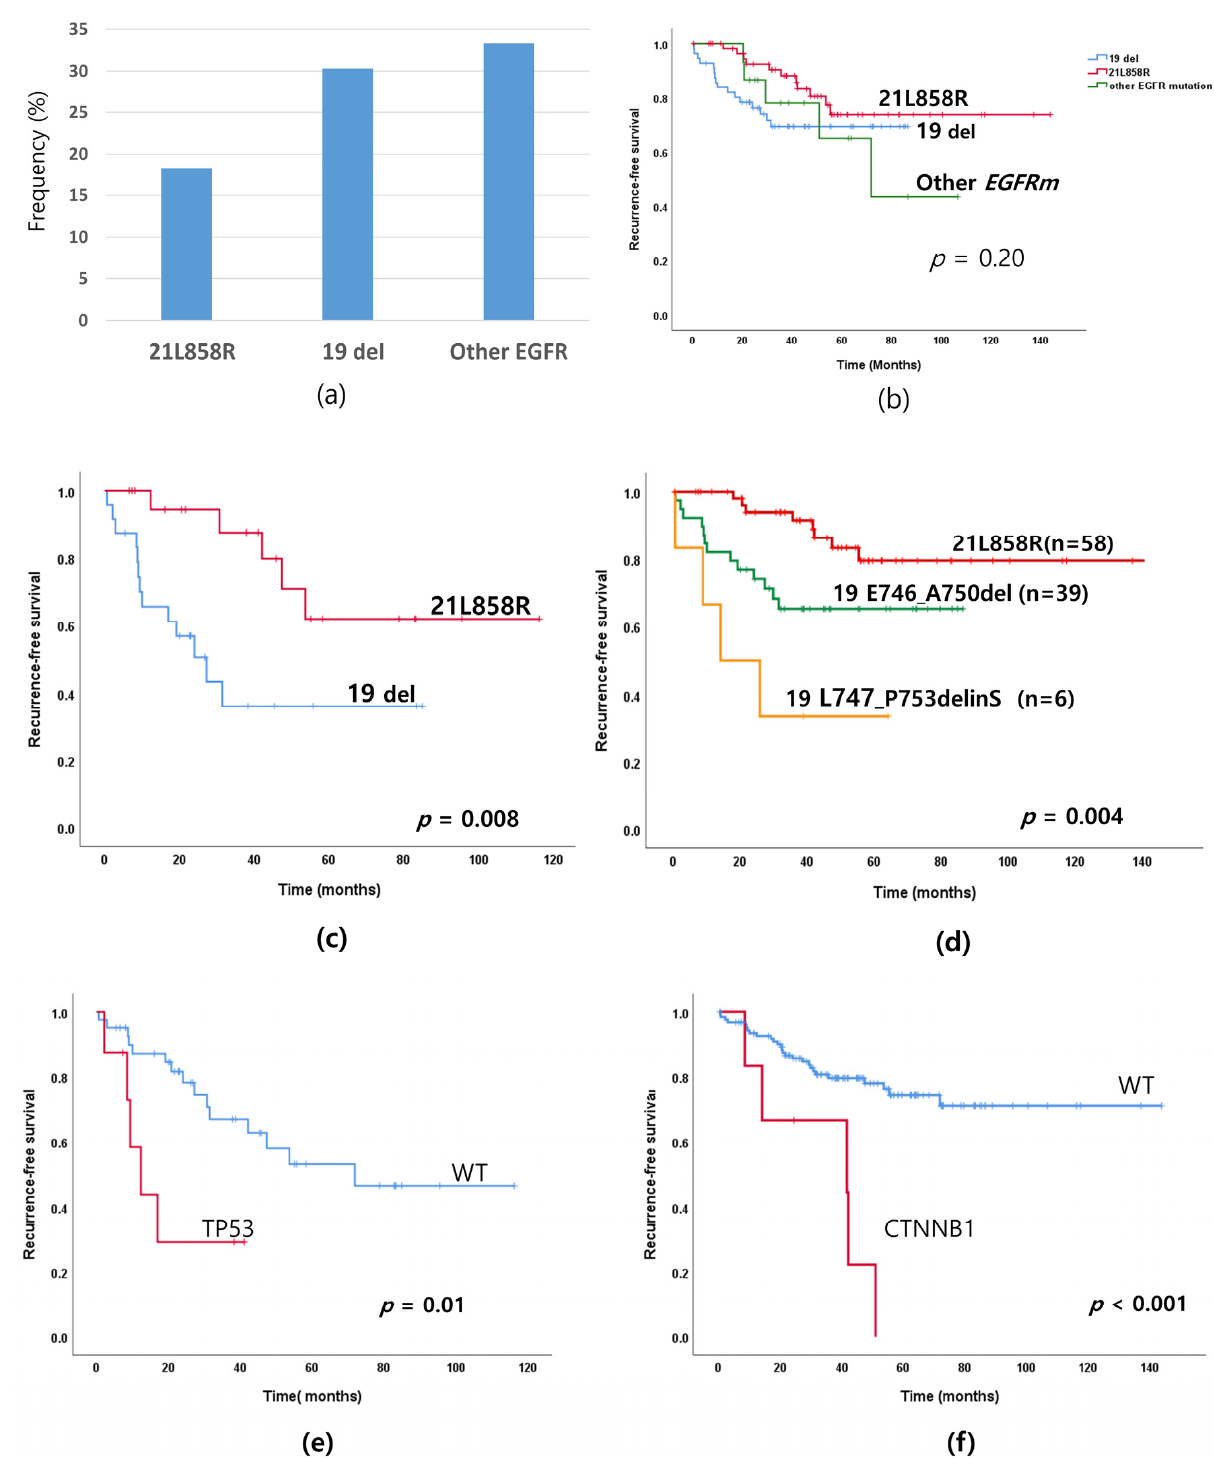
Figure 3. Recurrence-free survival (RFS) of EGFR mutation subtype in EGFR mutated lung adenocarcinoma. ( a ) Recurrence rate according to EGFR mutation types. ( b ) RFS according to EGFR mutation types in all cancer stages. ( c ) RFS according to EGFR mutation type in stage IB–IIIA cancer. ( d ) RFS according to the three most frequent EGFR mutations (E746_A750del, L747_P753delinS of 19-Del mutation, and 21L858R) in whole patients. ( e ) RFS according to the TP53 mutation in stage IB–IIIA cancer. ( f ) RFS according to the CTNNB1